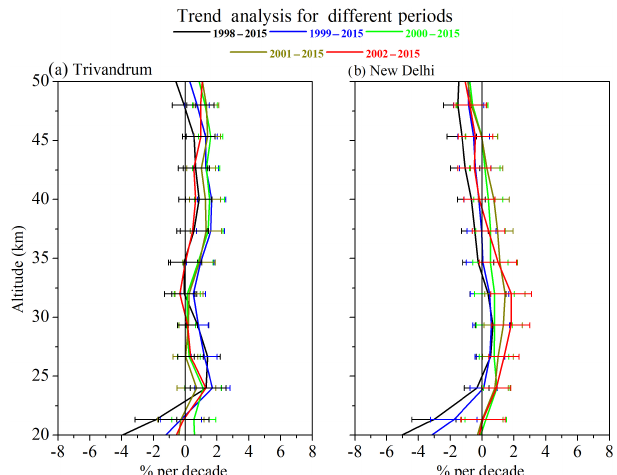
Figure A2. Ozone trend (%decade − 1 ) estimated over Trivandrum and New Delhi during different time